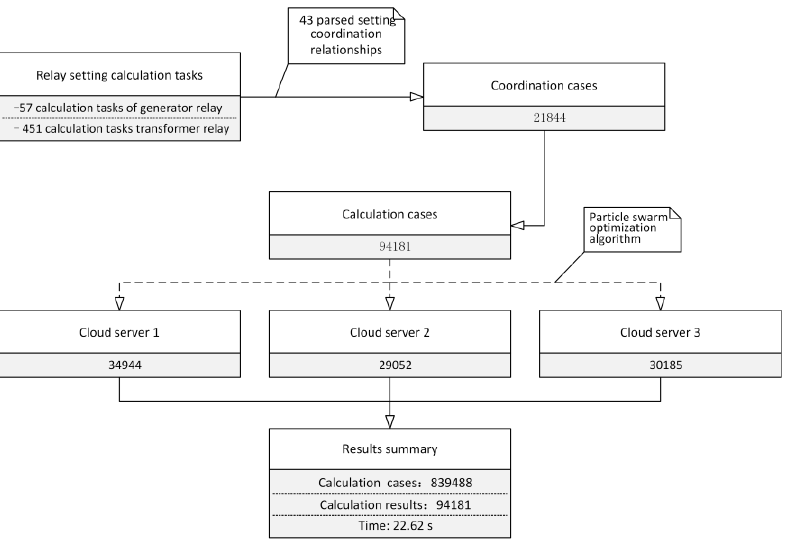
Figure 7. Setting calculation case of nuclear power plant.